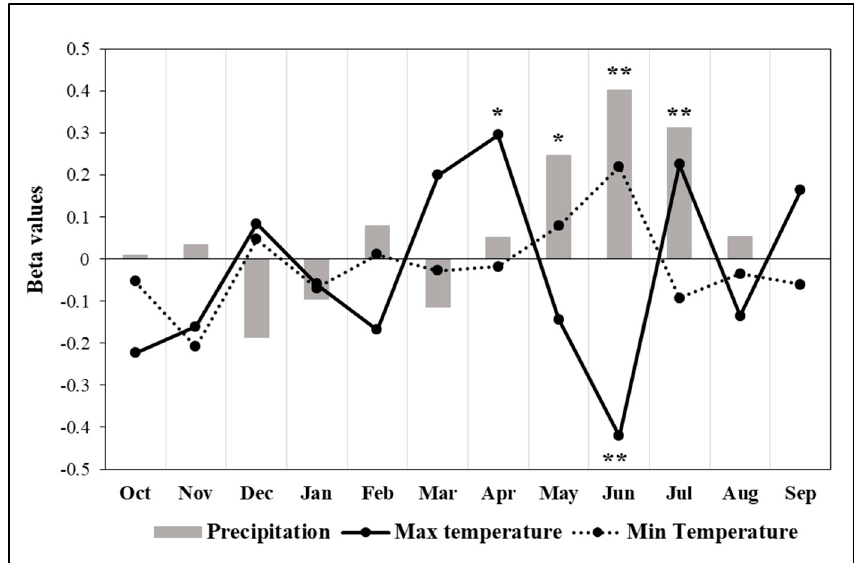
Figure 8. Response of tree-ring width to mean monthly precipitation, maximum and minimum temperatures of the hydrological year in Pertouli University Forest (significance of correlation: * p ≤ 0.05; ** p ≤ 0.01).